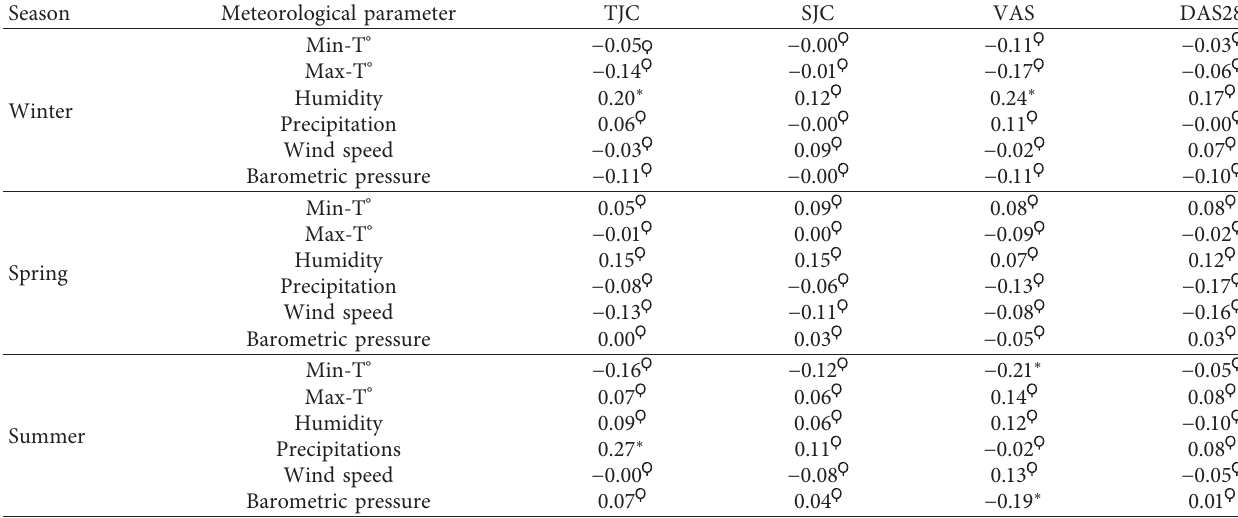
Table 3: Correlation coefficients between meteorological parameters and RA variables in studied